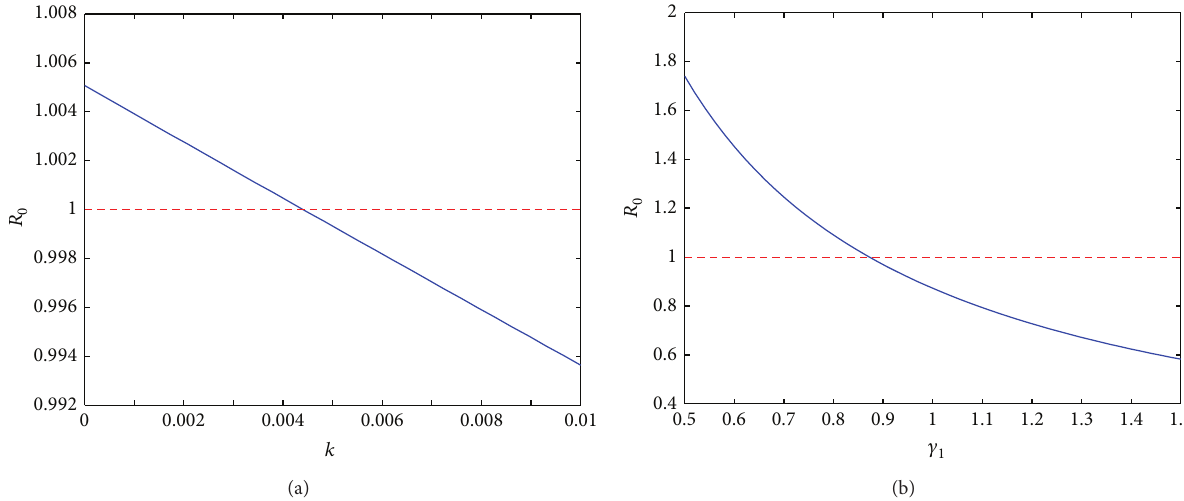
Figure 5: The influence of the quarantined rate 𝑘 (a) and infected recover rate 𝛾 1 (b) on 𝑅 0